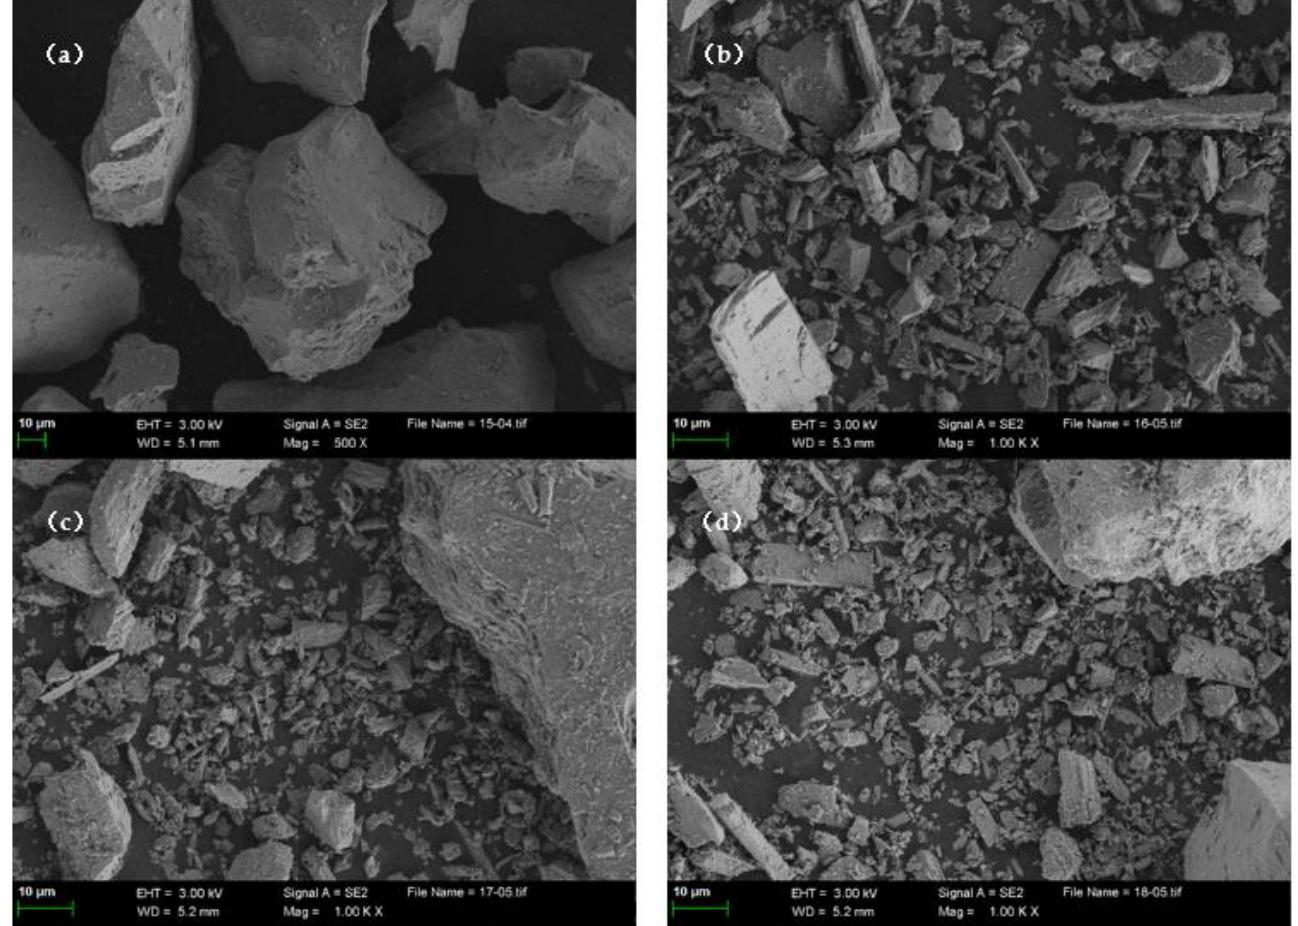
Figure 6. SEM images of ( a ) Grinding IOTs for 0 h, ( b ) Grinding IOTs for 1.5 h, ( c ) Grinding IOTs for 2 h, and ( d ) Grinding IOTs for 2 h.